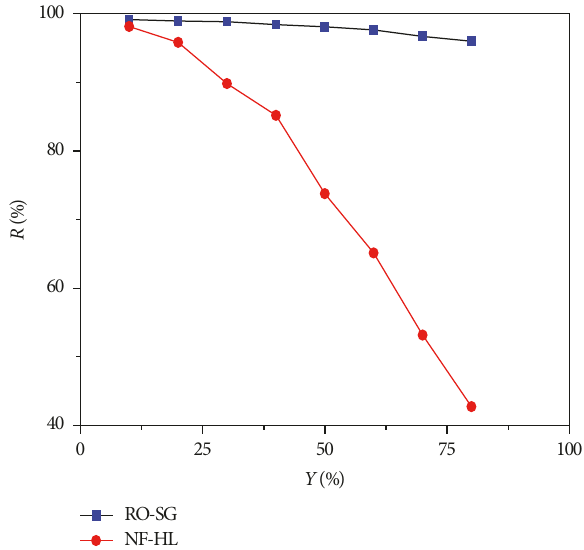
Figure 2: Retention rates of hexavalent chromium as a function of conversion rate ( Δ𝑃 = 6 bar, 𝐶 Cr ( VI ) = 11mg L −1 , pH = 8, and 𝜃 = 25 ∘